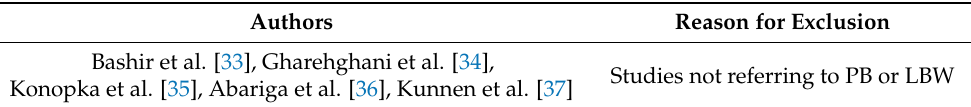
Table 2. Reason for exclusion of included